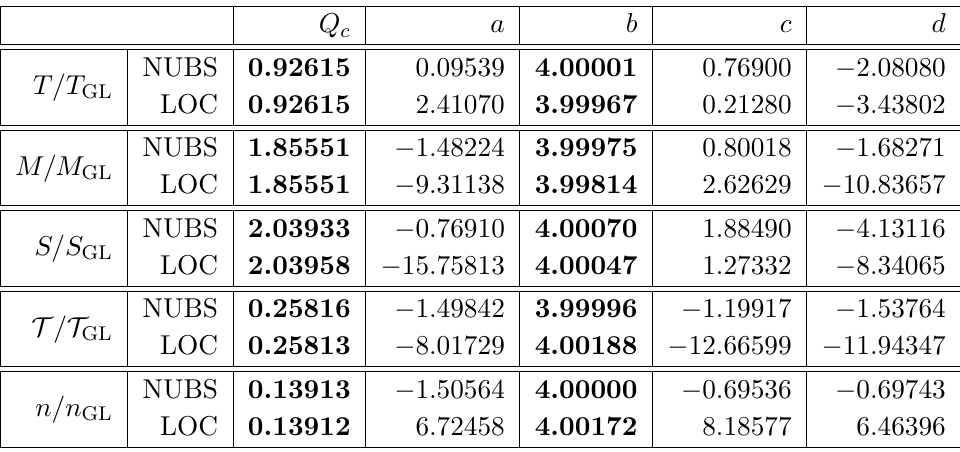
Table 1 . Critical exponent and other parameters obtained from the (cid:12)t of the non-uniform black strings (1st rows) and localized black holes (2nd rows) data